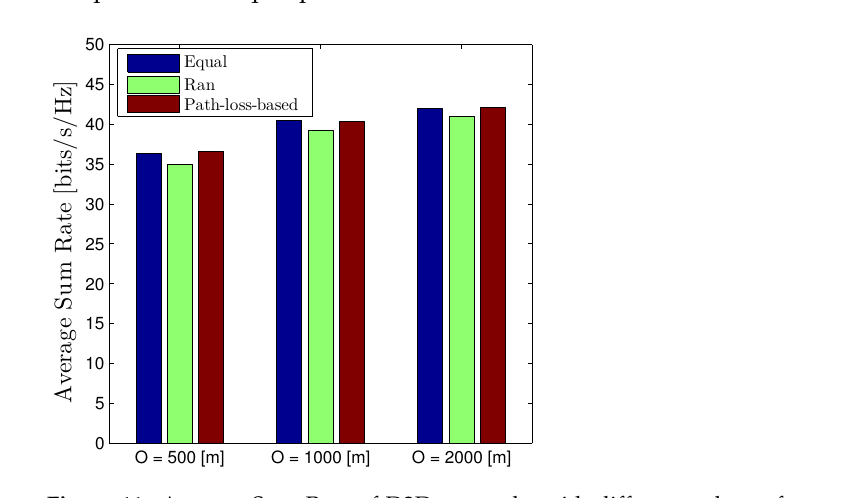
Figure 11. Average Sum Rate of D2D networks with different values of network radius O . The location of all devices (both D2D transmitters, receivers, and cellular users) are randomly distributed under the coverage area of the BS. Solid lines are plotted by employing